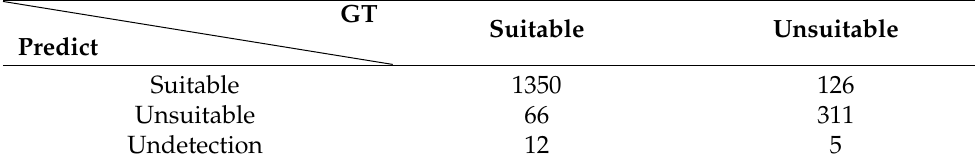
Table 3. The confusion matrix of diagnosis.